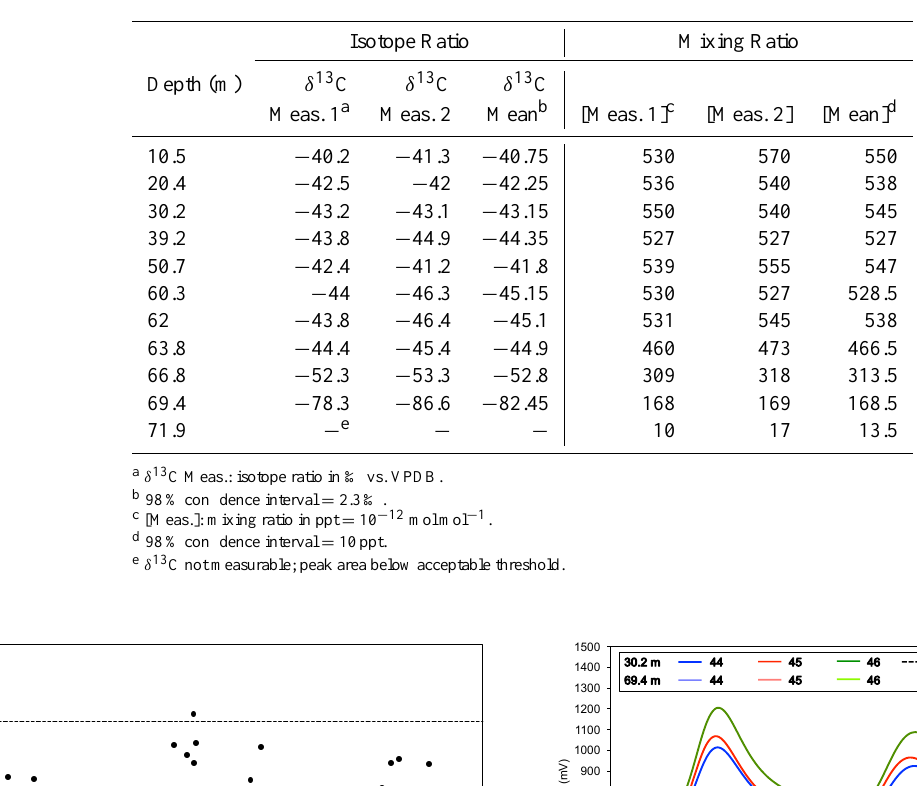
Table 1. Firn air CFC-12 δ 13 C and mixing ratio against depth, measurement series 1, 2 and mean.